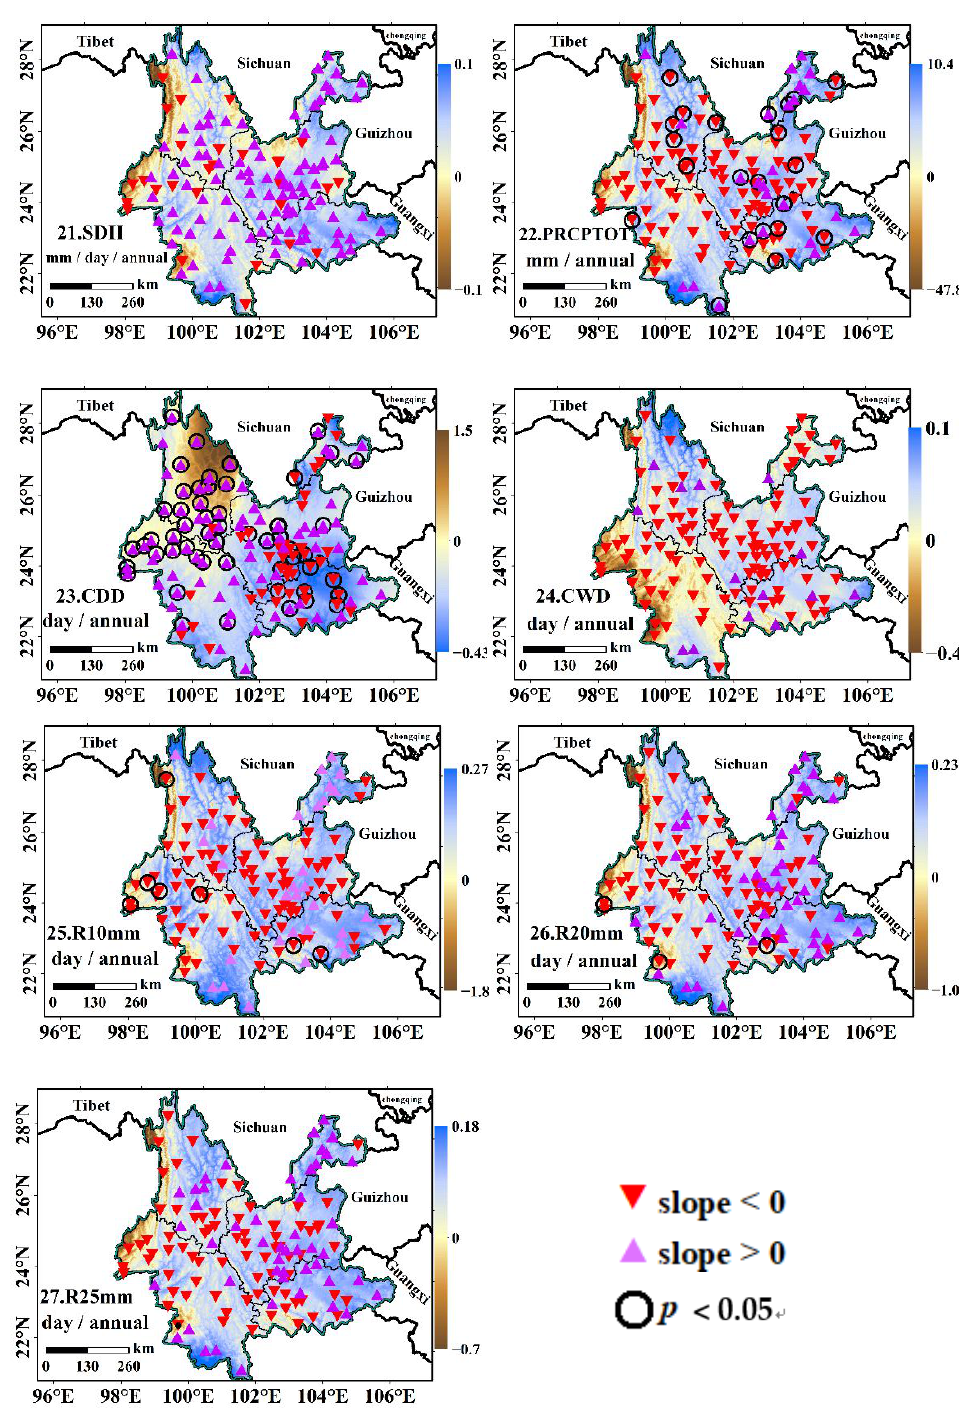
Figure 5. Spatial distribution of extreme precipitation indices variation trend in Yunnan. Space filling was carried out through ANUSPLIN method.